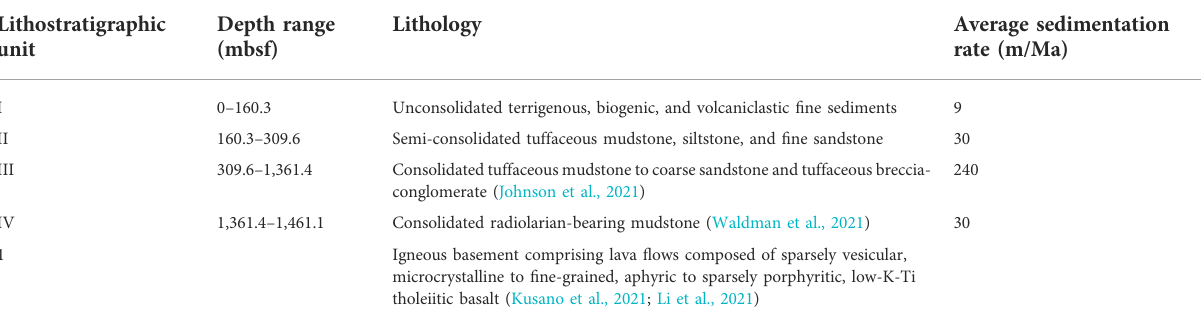
TABLE 1 Description of the lithostratigraphic units de fi ned at IODP Expedition 351, Stie U1438 (Arculus etal.,2015a), and average sedimentation rate as depicted from Figure 1. Lithostratigraphic